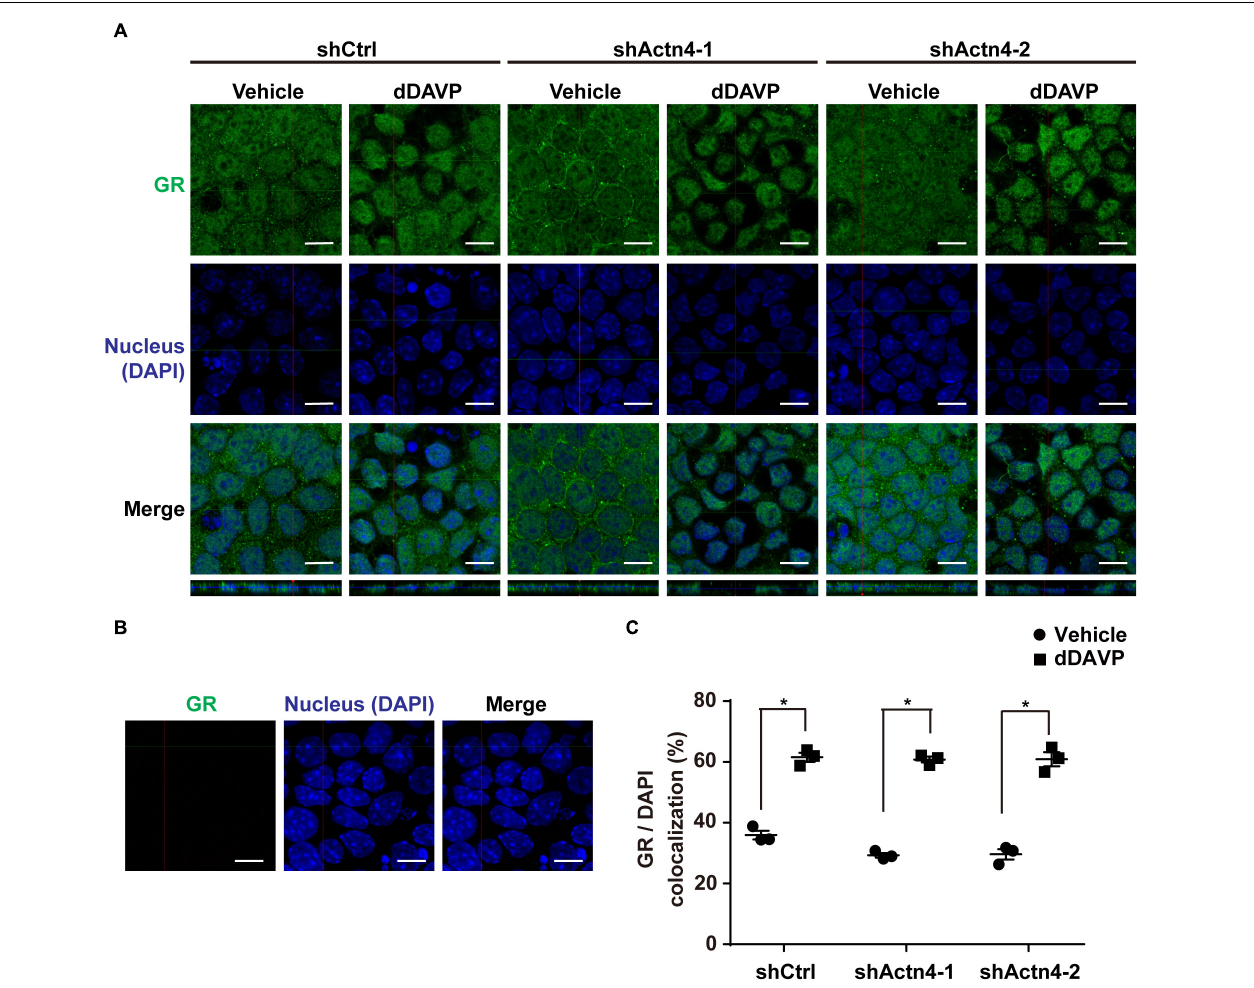
FIGURE 5 | Vasopressin-induced glucocorticoid receptor nuclear translocation was independent of α -actinin 4. (A,B) Confocal immunofluorescence micrographs of glucocorticoid receptor in control (shCtrl) and α -actinin 4 knockdown (shActn4-1 and shActn4-2) mpkCCD cells grown on Transwell R (cid:13) under vehicle vs. dDAVP (1 nM, 24 h) conditions. Bars indicate 10 µ m. The primary antibody to glucocorticoid receptor was omitted in (B) . (C) Summary of the confocal imaging results. Numbers are means ± SEM from three independent experiments, about 330 cells in each experiment. Asterisks indicate statistical significance, t -test p <